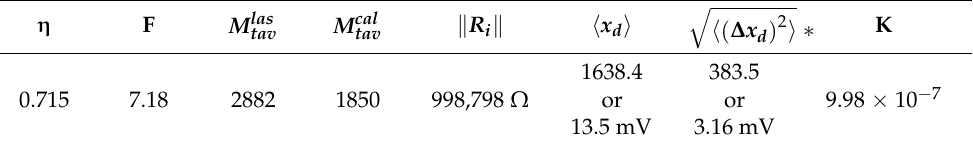
Table 4. Estimated value for the detector quantum efficiency, the detector noise factor, the speckle number both for the Earth signal and the calibration path, the response function norm, the offset value and the standard deviation of the electronic noise (in digital counts or in mV), and the K parameter defined by Equations (62) and